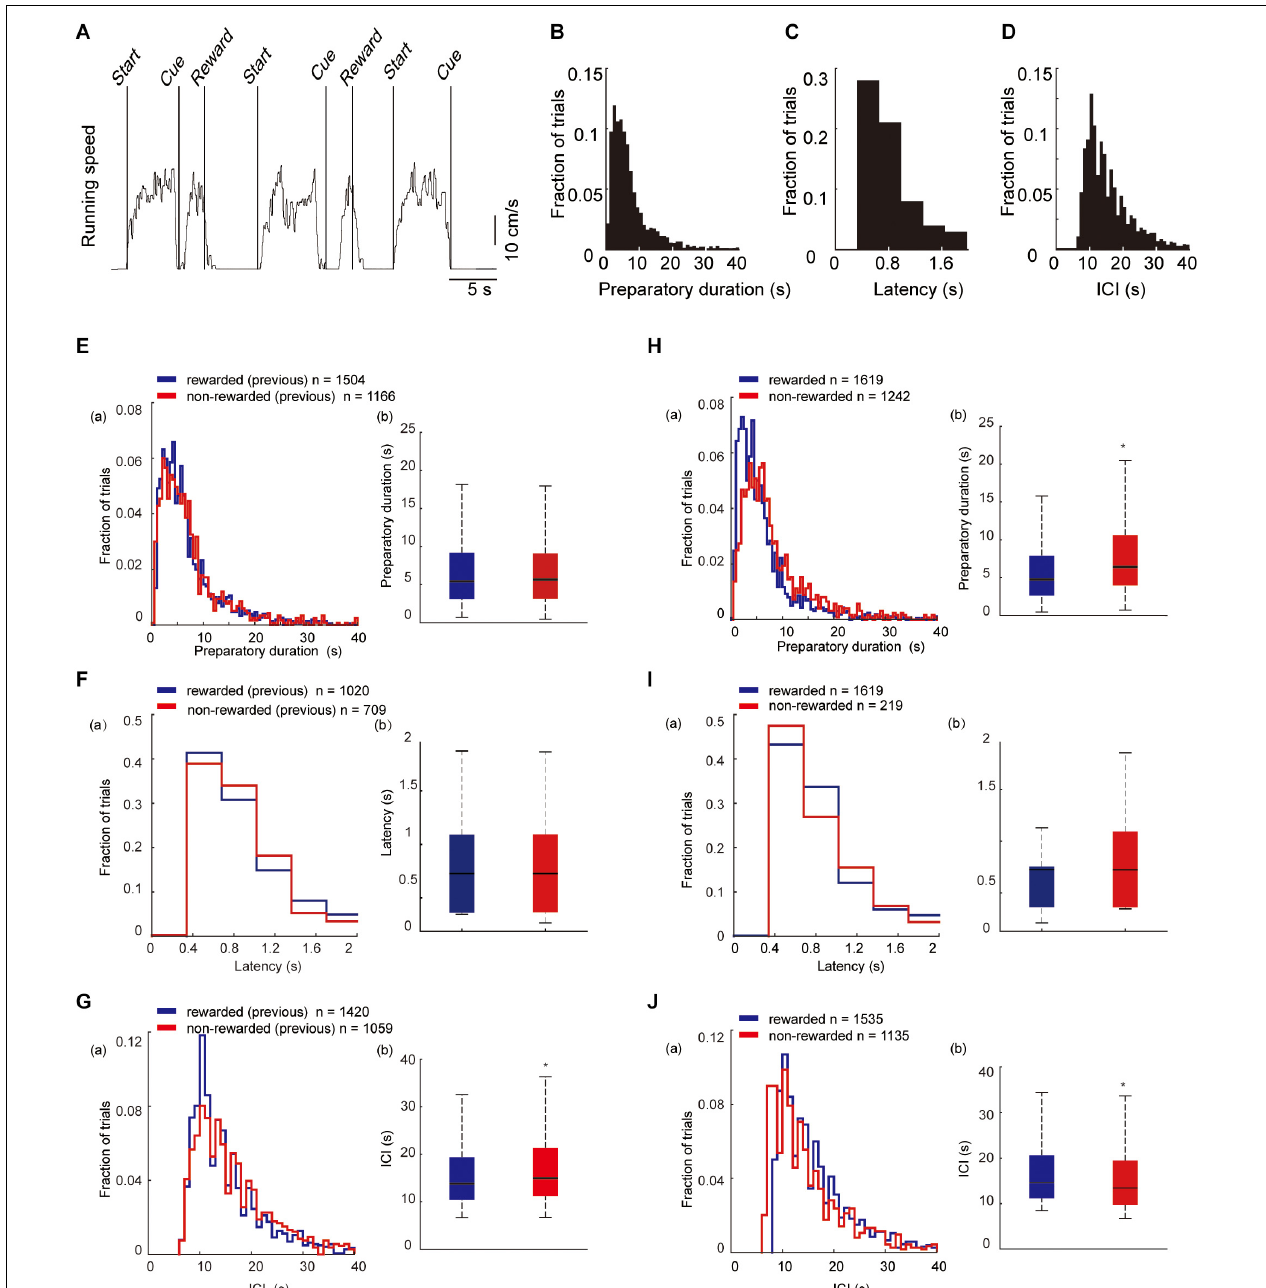
FIGURE 3 | Behavioral parameters in trials with different behavioral outcomes. (A) A representative trace recording of locomotion velocity. Start indicates the beginning of the preparatory run; Cue indicates the time of visual-cue presentation; and Reward indicates the time of reward delivery. (B–D) Histogram of the duration of the preparatory run ( n = 1,619). (E) Histogram of the latency to start the reward run after visual-cue presentation ( n = 1,157). (F) Histogram of the duration of ICI ( n = 1,535). (E–G) Histograms (a) and bar graphs (b) of the mean duration of the preparatory run, response latency, and ICI in trials that were preceded by a rewarded trial (blue) or by a non-rewarded trial (red). The duration of preparatory run (E) and latency (F) from first trials are not included in the analysis since they did not have a previous outcome. The ICI (G) between the first trial and the second trial were excluded as well. (H–J) Histograms (a) and bar graphs (b) of the mean duration of the preparatory run, latency, and ICI in rewarded (blue) and non-rewarded (red) trials. Statistical differences were calculated by two-sided Wilcoxon signed-rank test (* p < 0.05). ( E b) n = 2,670 trials, z = − 1.75, P = 0.08; ( F b) n = 1826 trials, z = 0.57, P = 0.58; ( G b) n = 2,479 trials, z = − 4.47, P = 7.91E-6; ( H b) n = 2,479 trials, z = − 10.11, P = 4.95E-24; ( I b) n = 1,834 trials, z = − 0.20, P = 0.83; ( J b) n = 2,670 trials, z = 7.65, P = 1.95E-14). In box plots, the central mark indicates the median and the bottom and top edges of the box indicate the 25th and 75th percentiles, respectively. Whiskers extend to the most extreme data points not considered